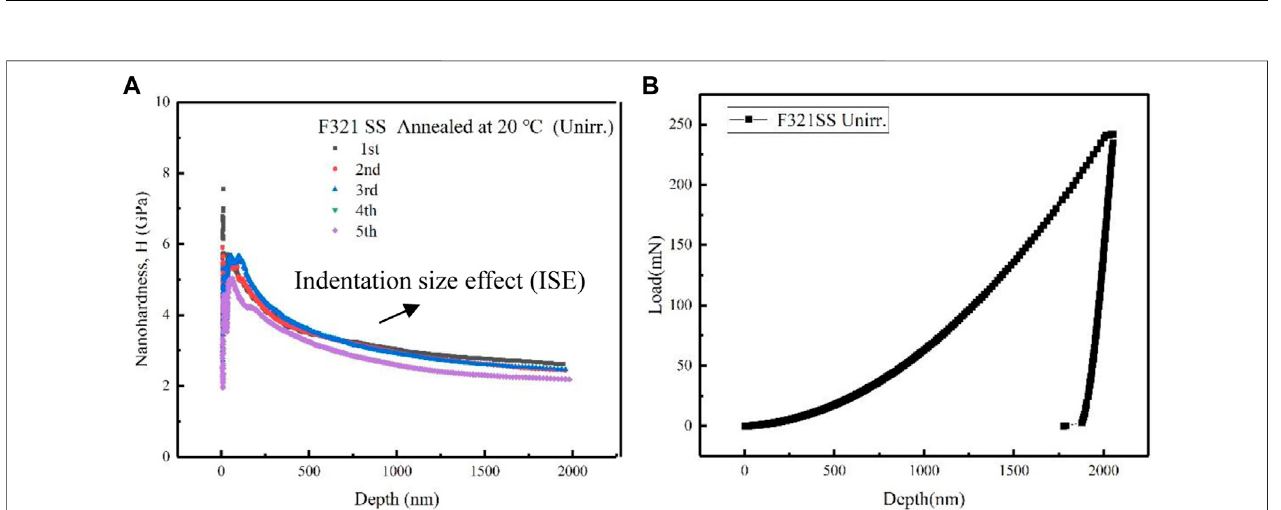
FIGURE 3 | Depth dependence of (A) the nanoindentation hardness and (B) the load of the unirradiated F321 austenitic stainless steel.